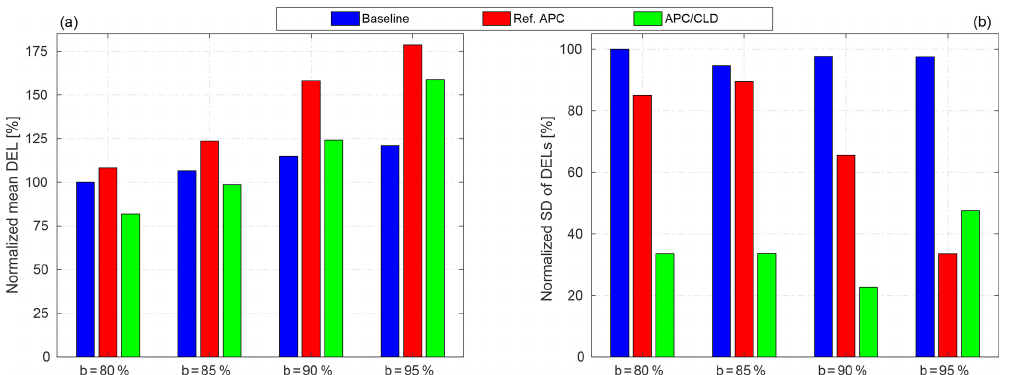
Figure 20. Normalized mean (a) and standard deviation (b) of the corresponding DELs of the tower base fore–aft bending moment for = 12 . 3MW, b = 80%, 85%, 90%, 95%, respectively, and c = different levels of AGC power reference (Eq. 23), parameterized as P base farm 10%. The baseline case with power demand level b = 80% is considered the